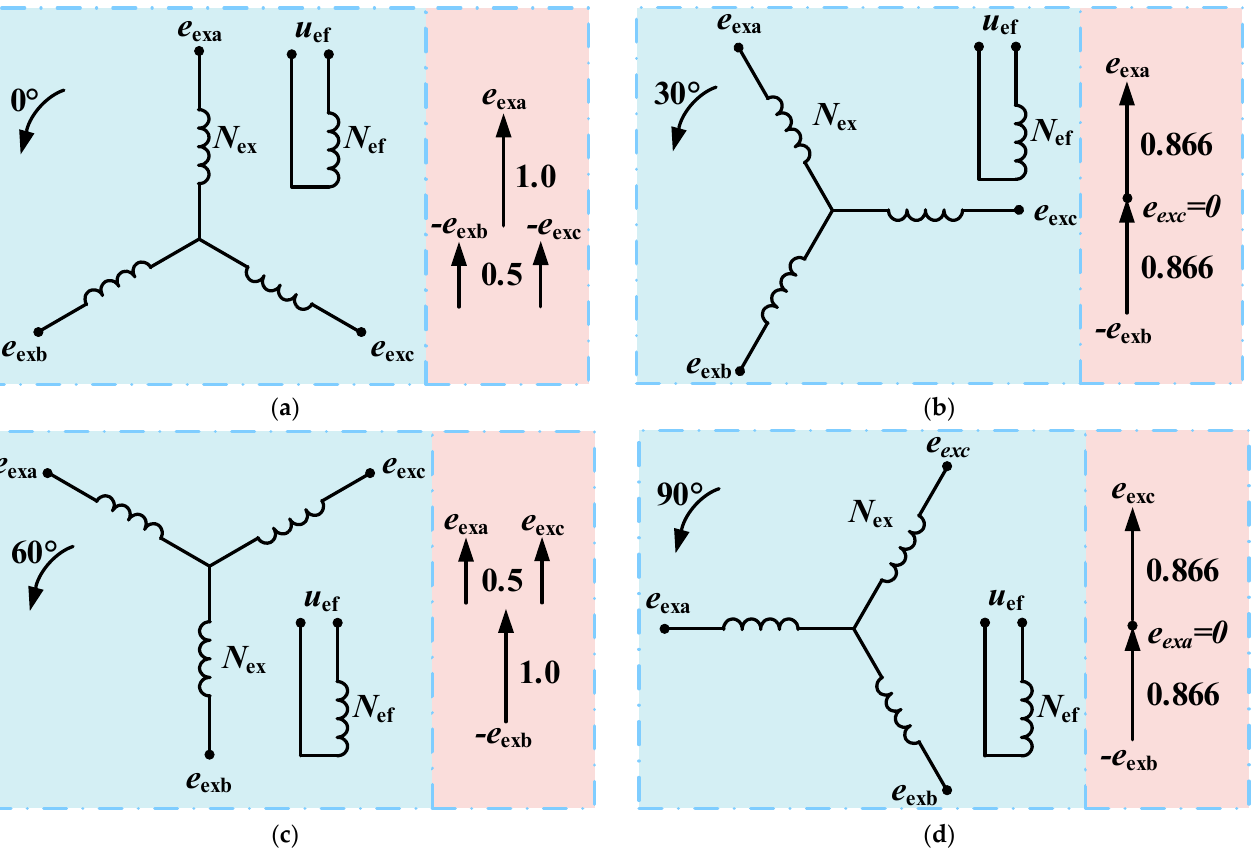
Figure 8. The EMF of exciter armature winding under different rotor position angles. ( a ) The angle between the phase A winding axis and the exciting winding axis is 0°; ( b ) the angle between the phase A winding axis and the exciting winding axis is 30°; ( c ) the angle between the phase A winding axis and the exciting winding axis is 60°; ( d ) the angle between the phase A winding axis and the exciting winding axis is 90°.